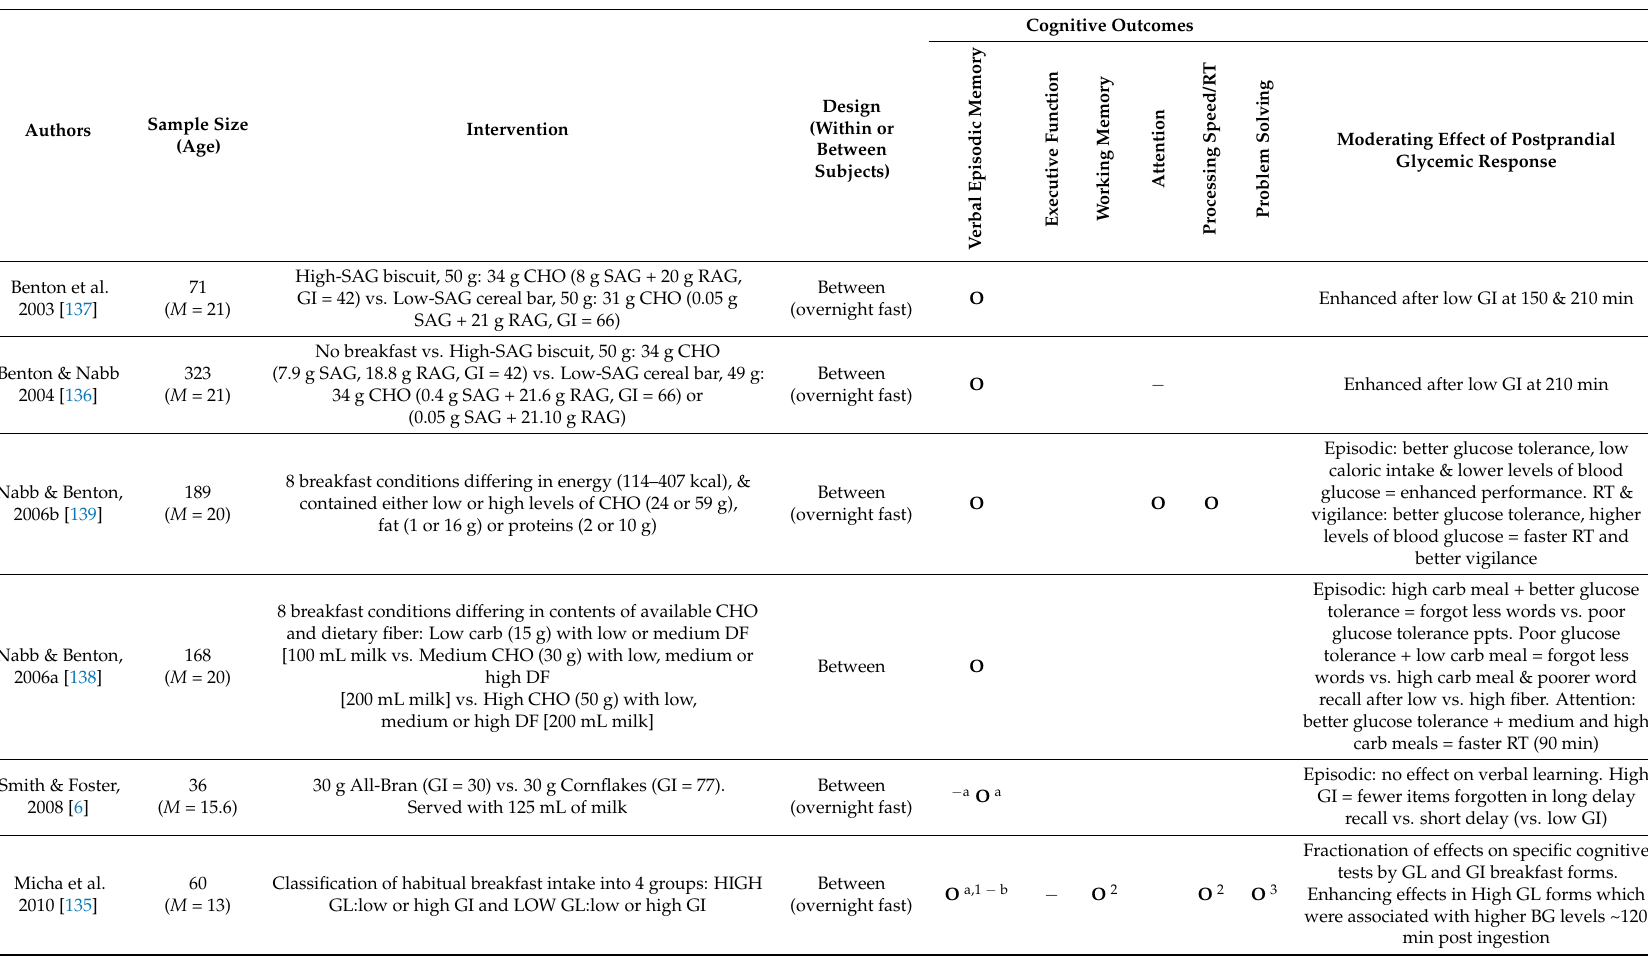
Table 4. Summary of studies examining the effects of manipulating glycemic response on cognitive performance